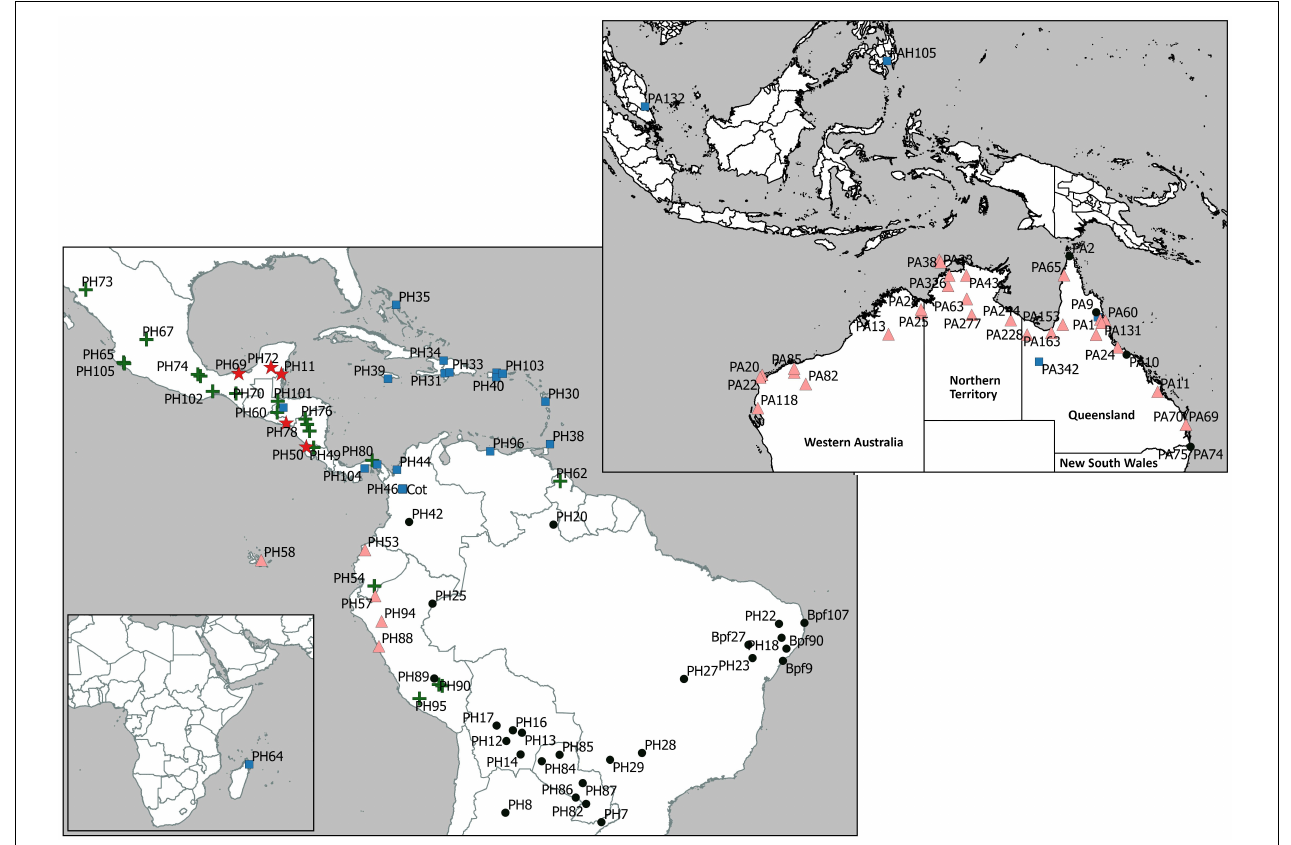
FIGURE 3 | Geographic location of Passiflora foetida sensu lato samples used in this study ( foetida dataset), from the native range in Central and South America and introduced range in Australia, South-East Asia and Africa (Madagascar), grouped according to the five sub-clades (each identified with a different symbol) in the phylogenetic tree shown in Figure 2